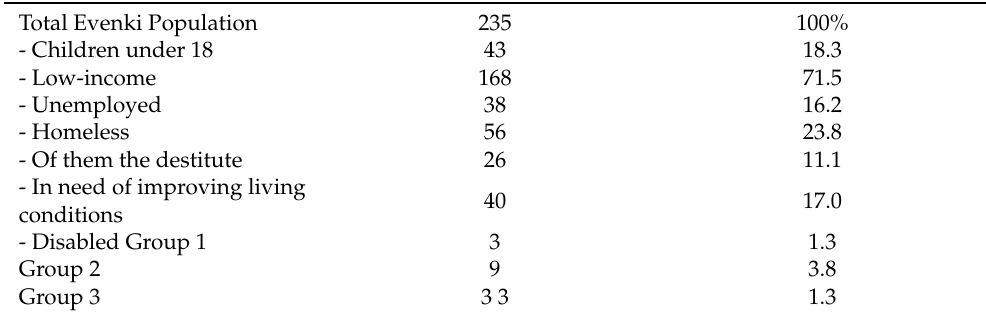
Table 5. Socioeconomic situation of the Evenki in Tommot. Source: data of the association of indigenous peoples of the city of Tommot for